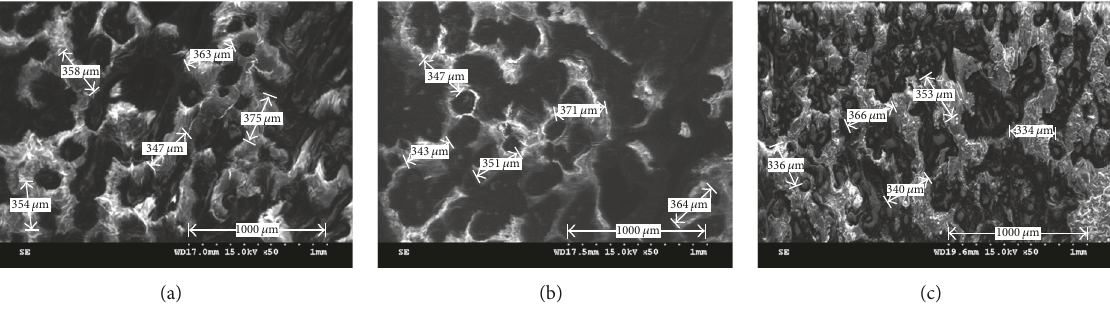
Figure 11: The photographs of the micrographic surface for 𝑅 measuring: (a) sample #1; (b) sample #2; (c) sample #3.